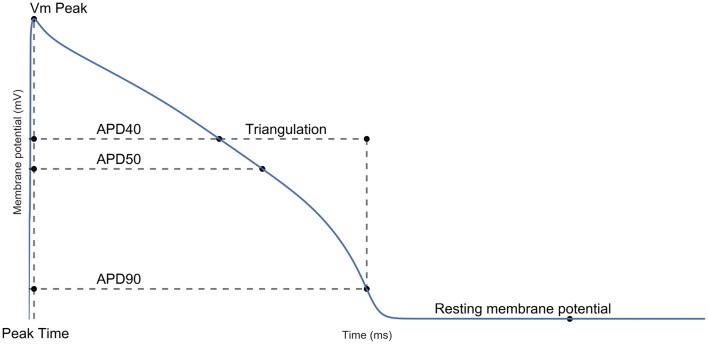
Action potential biomarkers. Peak membrane potential (Vm Peak); time of peak membrane potential (Vm Time); AP duration (APD) at 40/50/90% repolarization; triangulation and resting membrane potential (RMP). Each biomarker was calculated as defined in the Supplementary Material.